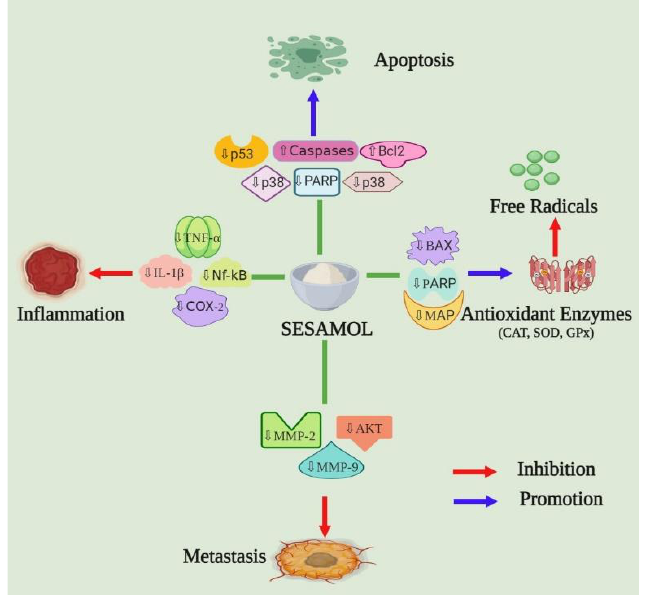
Figure 2. The basic mechanism of action of sesamol includes an increase in free radical scavenging, upregulation of various antioxidant enzymes, suppression of IL-1 β , TNF α , LOX-1, and 5-LOX expressions, inhibition of NF- κ B signaling, induction of cell apoptosis, cell cycle arrest and modulation of p53, caspase, Bcl2, and Bax expressions.